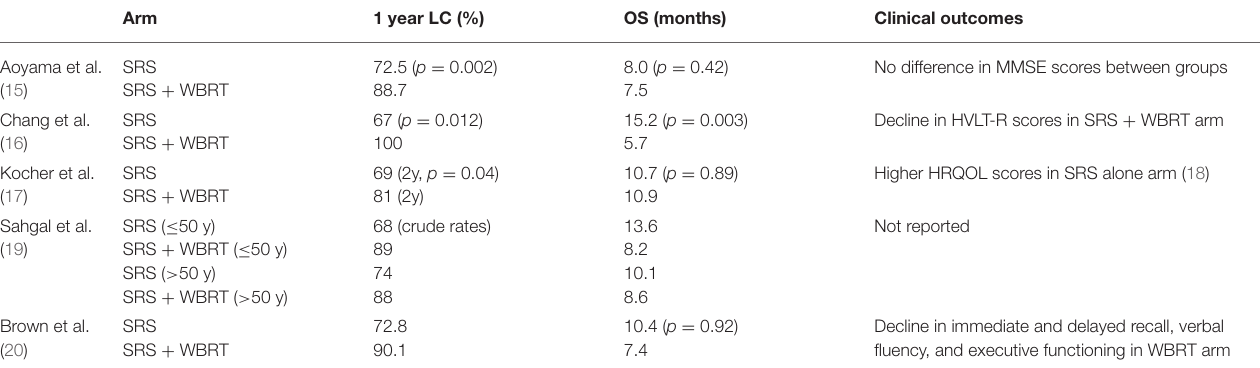
TABLE 1 | Summary of SRS alone vs. SRS +